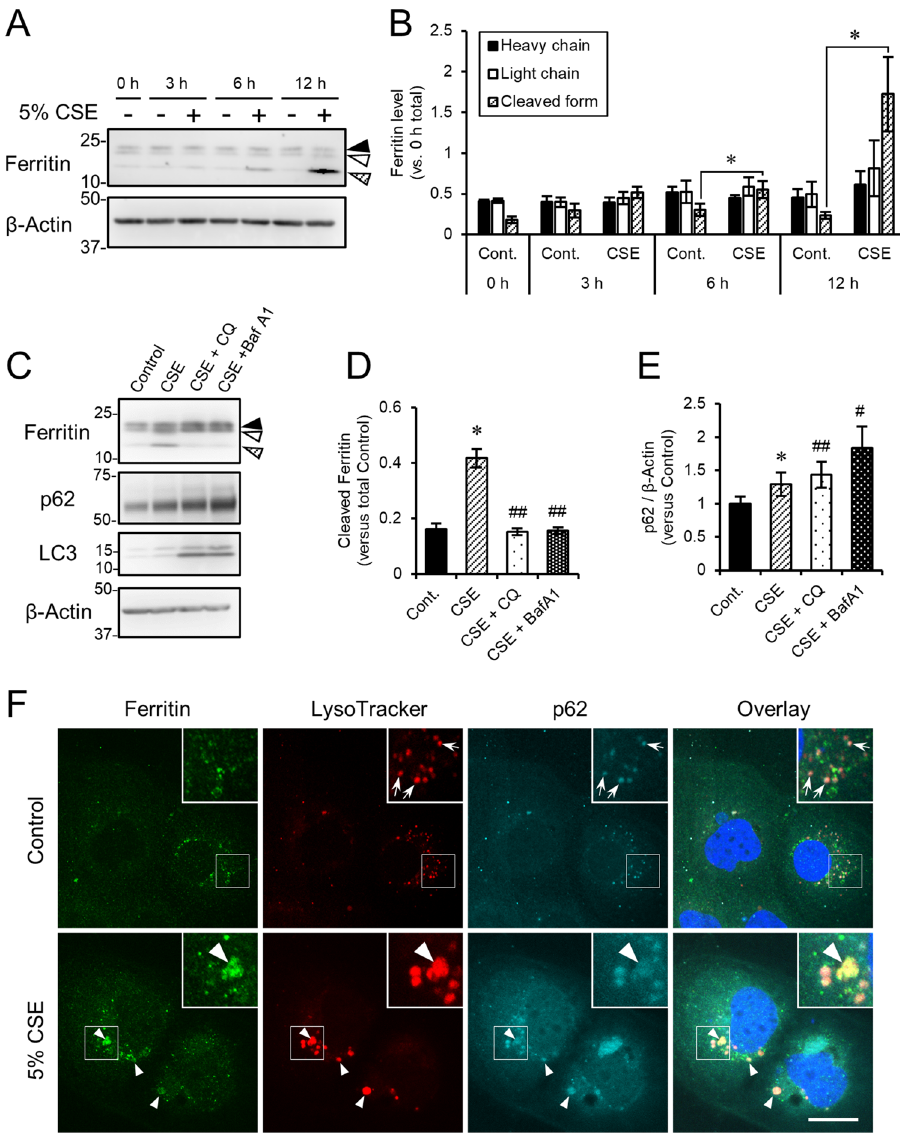
Figure 3. Exposure of HCE-T cells to CSE resulted in aberrant autophagic ferritin processing and accumulation of a cleaved form of ferritin. ( A , B ) HCE-T cells were exposed to CSE for the indicated times. Protein lysates were then analyzed by immunoblotting using antibodies directed against ferritin and β-actin (loading control). ( B ) Quantitation of the fold increase of each form of ferritin (heavy chain, black arrowheads; light chain, white arrowheads; cleaved form, arrowheads filled with diagonal lines) after exposure to CSE. ( C – E ) HCE-T cells were incubated without (control) or with 5% CSE in the absence or presence of either 25 µM chloroquine (CQ) or 10 nM bafilomycin A1 (BafA1) for 24 h. Protein lysates were then analyzed by immunoblotting using the indicated antibodies. ( D , E ) show the quantification of ferritin (the cleaved form) and p62, respectively, both normalized to β-actin. ( F ) Representative images of intracellular ferritin distribution in HCE-T cells with or without 5% CSE exposure for 12 h. The cells were stained with anti-ferritin antibody (green), LysoTracker Red (red), anti-p62 antibody (cyan), and Hoechst 33342 (blue). The boxed regions are enlarged at the upper right corners. The arrows represent p62 and LysoTracker Red double positive organelles, which comprise autolysosomes. The arrowheads show the autolysosomes that contain ferritin. Bar = 20 µm. The data are represented as the mean ± SEM (n = 6). * P < 0.05, Student’s t -test vs. Control (Cont); # P < 0.05, ## P < 0.005, Student’s t -test vs.